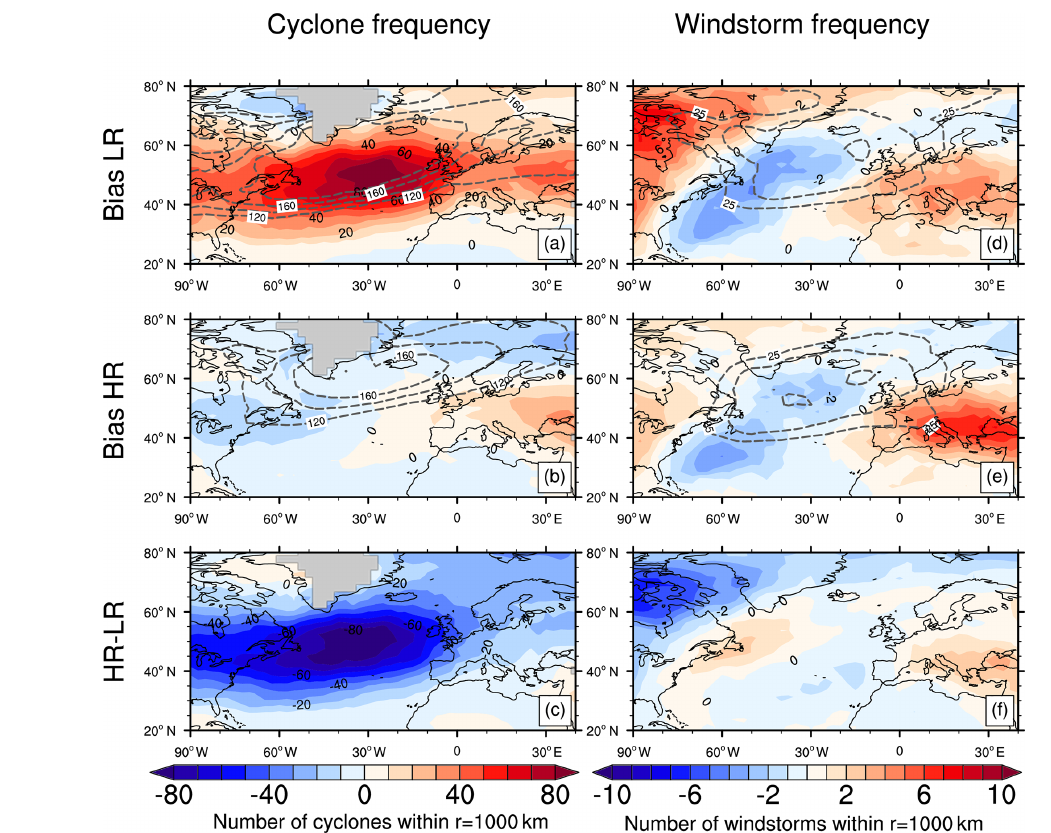
Figure 3. Same as Fig. 2 but for the cyclone frequency (a–c) and the windstorm frequency (d–f) . The grey contours, i.e., ensemble mean climatology, have the same levels as in Fig. 1: 120–180 by 20 cyclones for the cyclone frequency and 25–30 by 2.5 storms for the windstorm frequency.